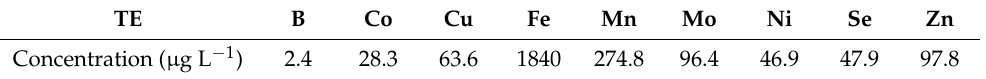
Table 1. Composition of the TE mix (as reported by van de Graaf and colleagues [34]). TE B Co